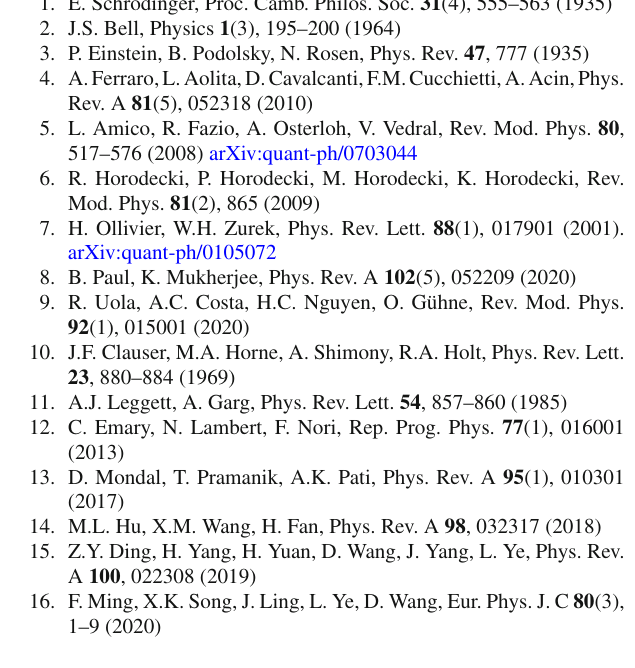
Fig. 3 Variation of f a (green), f b (blue) and f c (red) with energy ( E ) for the accelerator and reactor experiments: a upper left: DUNE, L = 1300 km, E ≈ 1 − 14 GeV; b upper middle: MINOS, L = 735 km, E ≈ 1 − 10 GeV; c upper right: T2K, L = 295 km, E ≈ 0 − 6 GeV; d lower left: KamLAND, L = 180 km, E ≈ 1 − 16 MeV; and e